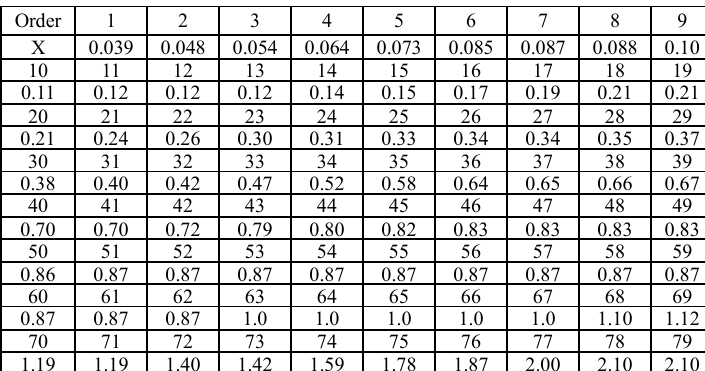
Table 1. The statistics of fuzzy value W * / D 0 (let X= W * / D 0 , unit: %)